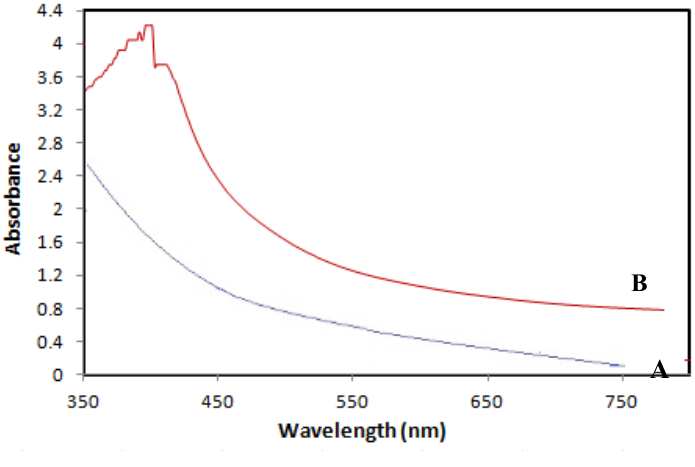
O /BS extract (B). 3 4